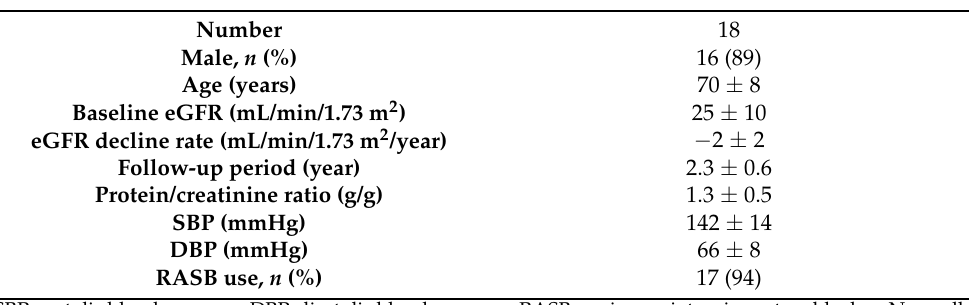
Table 1. Patient